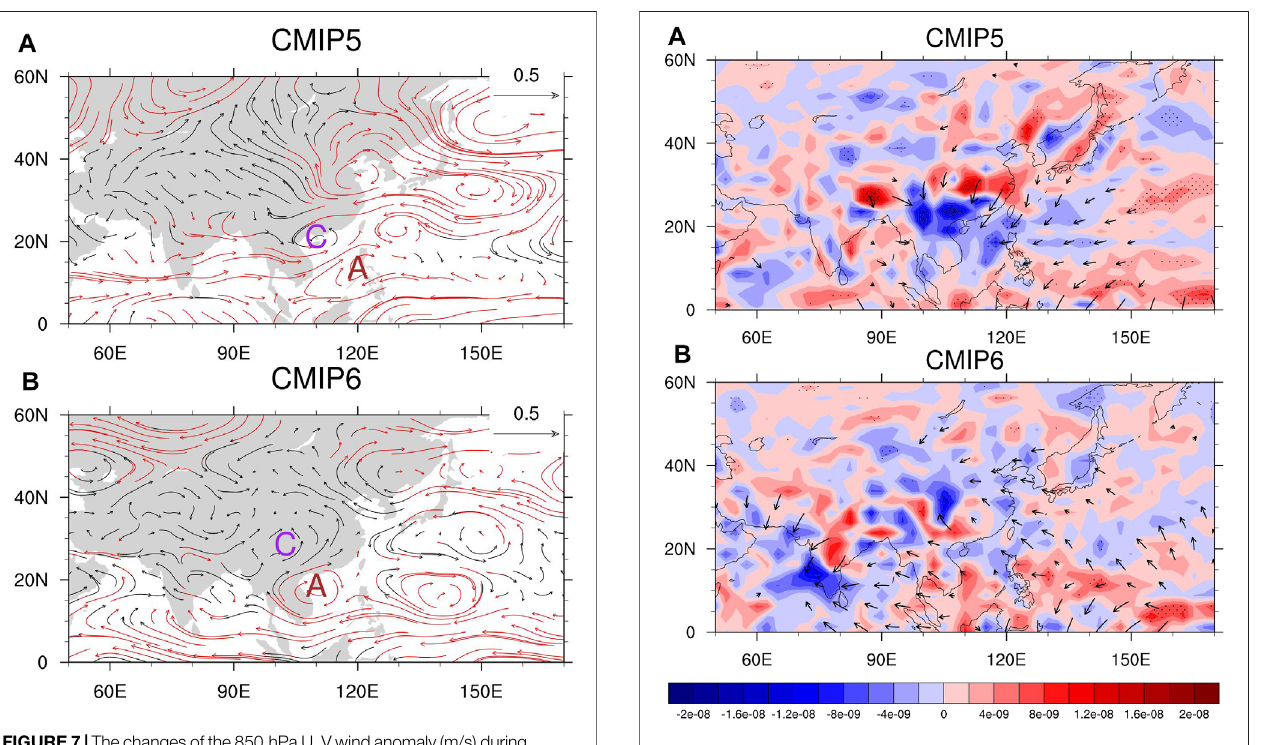
Frontiers in Earth Science |